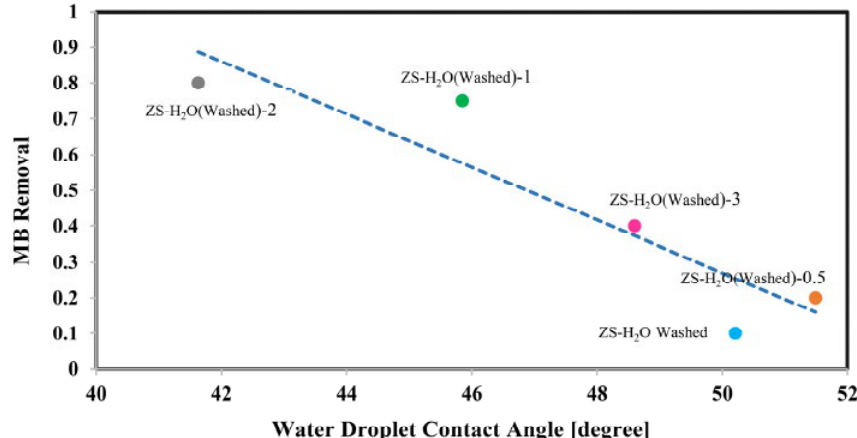
Fig. 8. Compatibility between the results of the adsorption testing and values of water droplet contact Figure 8 . Compatibility between the results of the adsorption testing and the values of water droplet contact angle